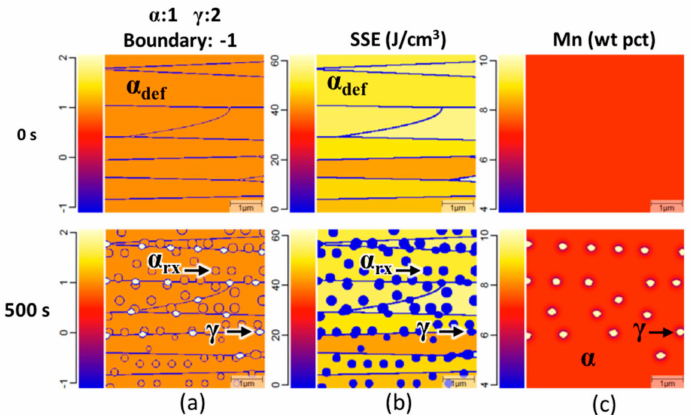
Figure 8. Exemplary MICRESS ® simulation results of intercritical annealing with an isothermal holding temperature of 650 ◦ C and a heating rate of 96 ◦ C / s. Timesteps are shown at 0 and 500 s. In the phase maps: ( a ) The simulation is shown to initially contain only deformed ferrite; after 500 s the phase map shows the presence of homogenously nucleated recrystallized ferrite and ferrite grain boundary nucleated austenite. The stored strain energy maps ( b ) shows that the deformed ferrite has a distribution of stored strain energy and that recrystallized ferrite and austenite have no stored strain energy. The medium-manganese (Mn) distribution map ( c ) shows the simulation initially has a homogenous distribution of Mn and that austenite growth occurs with an enriched Mn